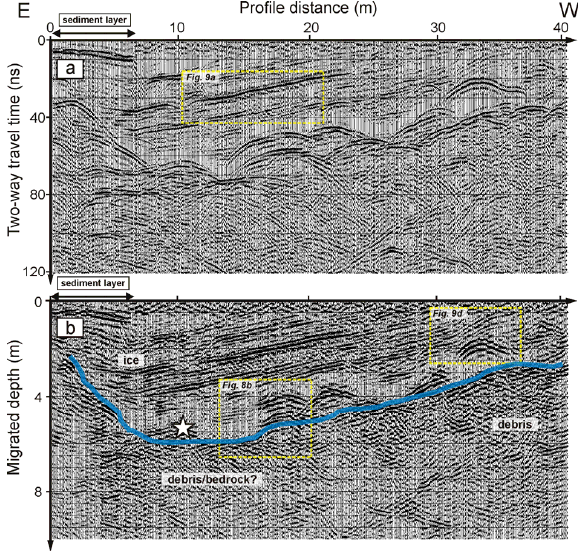
Figure 4: Radargram section (a) from the location "Saarhalle" (Dachstein-Mammuthöhle). The white star indicates the maximum depth of a core drilling taken for isotopic analyses (Kern, 2010). The blue line in the migrated section (b) shows the interpreted base. Note the strong layering inside the ice in the uppermost 4 meters and the marked visible shallow sediment layer (dipping from 0.4 to 1 m depth). Remarkable is the inclination of the internal layers which is parallel to the base topography. A picture of an outcrop which runs perpendicular to the GPR section at the profile distance of 30 m is shown in Fig. 2b.